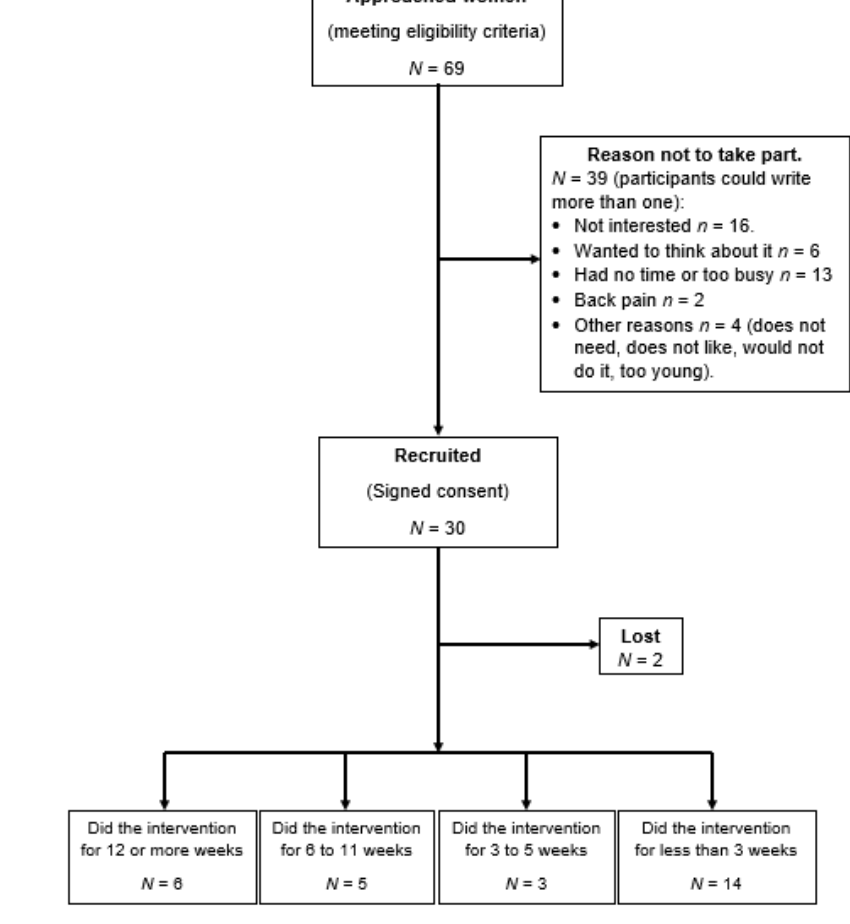
Figure 1. Flow chart of recruitment process.